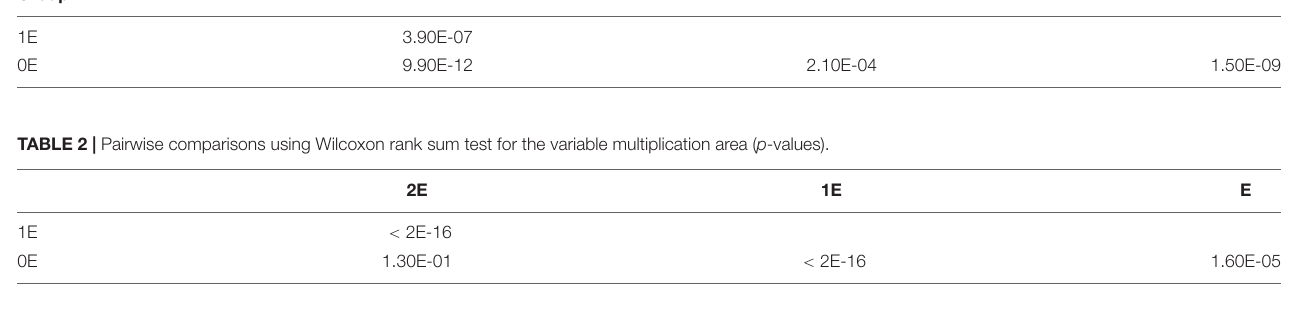
TABLE 1 | Pairwise comparisons using Wilcoxon rank sum test for the variable grain yield ( p -values). Group 2E